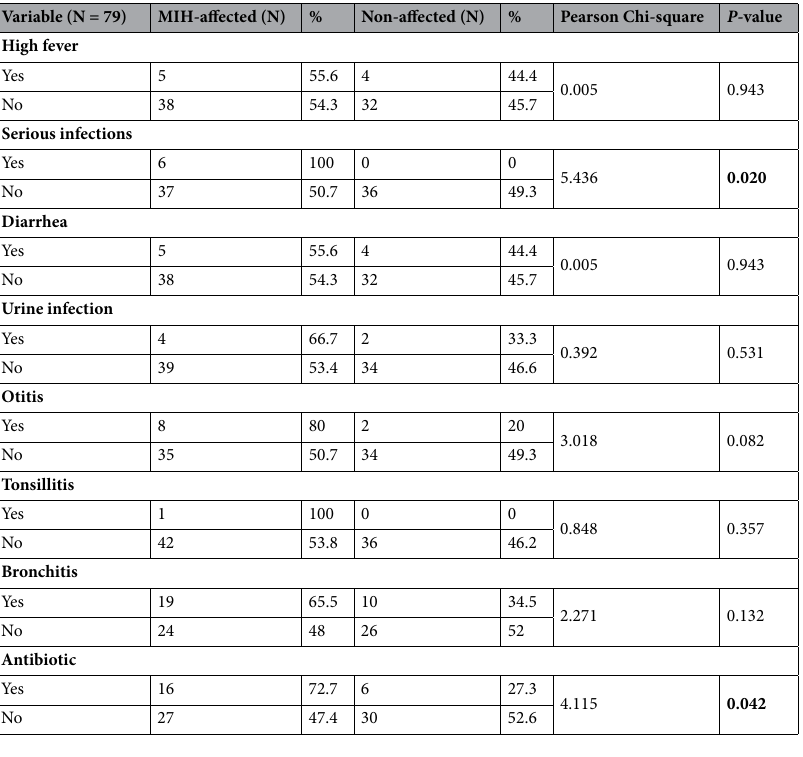
Table 2. Diseases suffered during the first year of